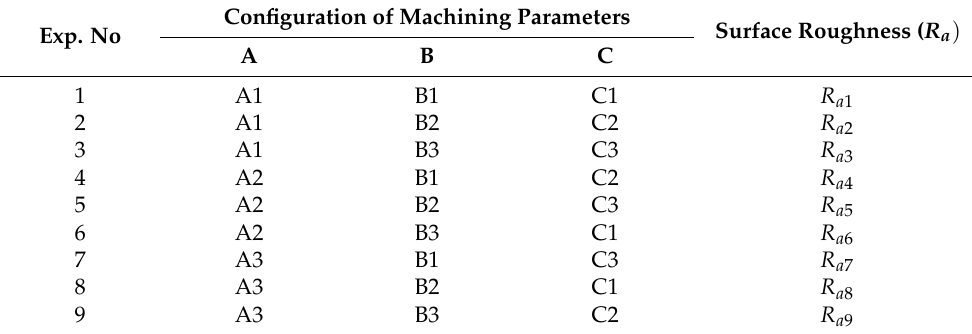
Table 6. Configuration of EP machining parameters.